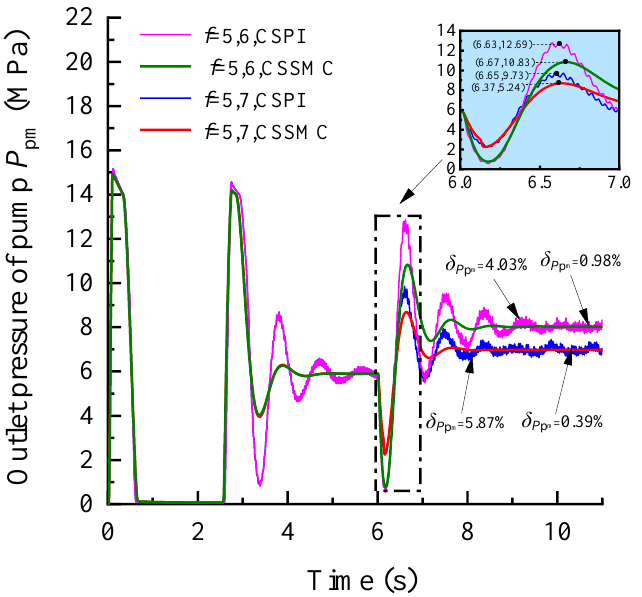
Figure 9. Variation curve of the hydraulic pump outlet pressure based on the CSPI and CSSMC.